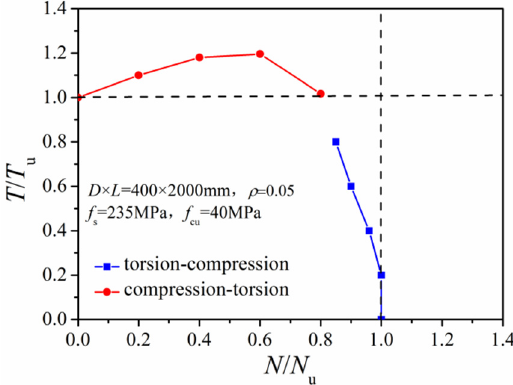
Figure 6. Comparison of N/N u ~T/T u relationships under different loading paths.